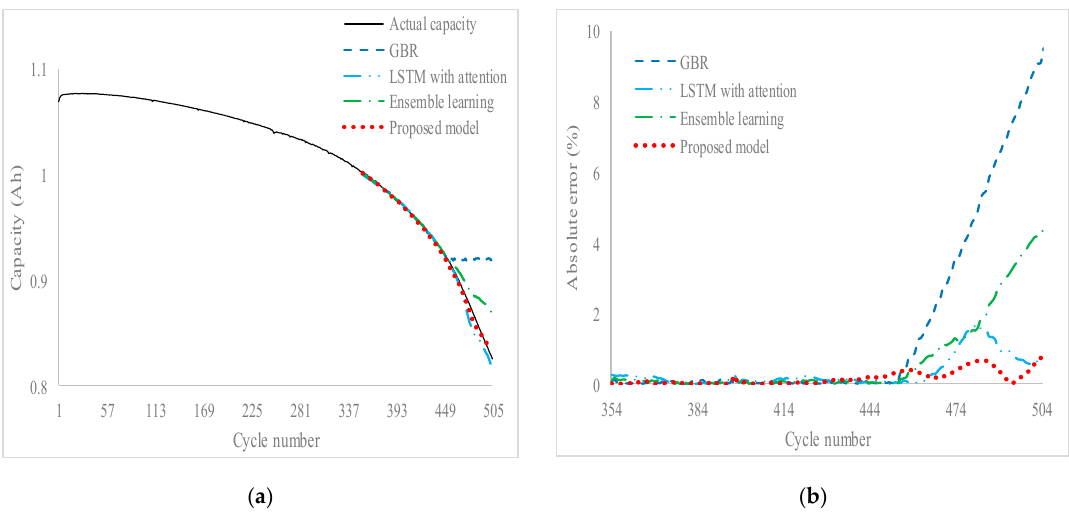
Figure 4. Prediction performance of different models on cell #2_12: ( a ) prediction performance and ( b ) absolute error.